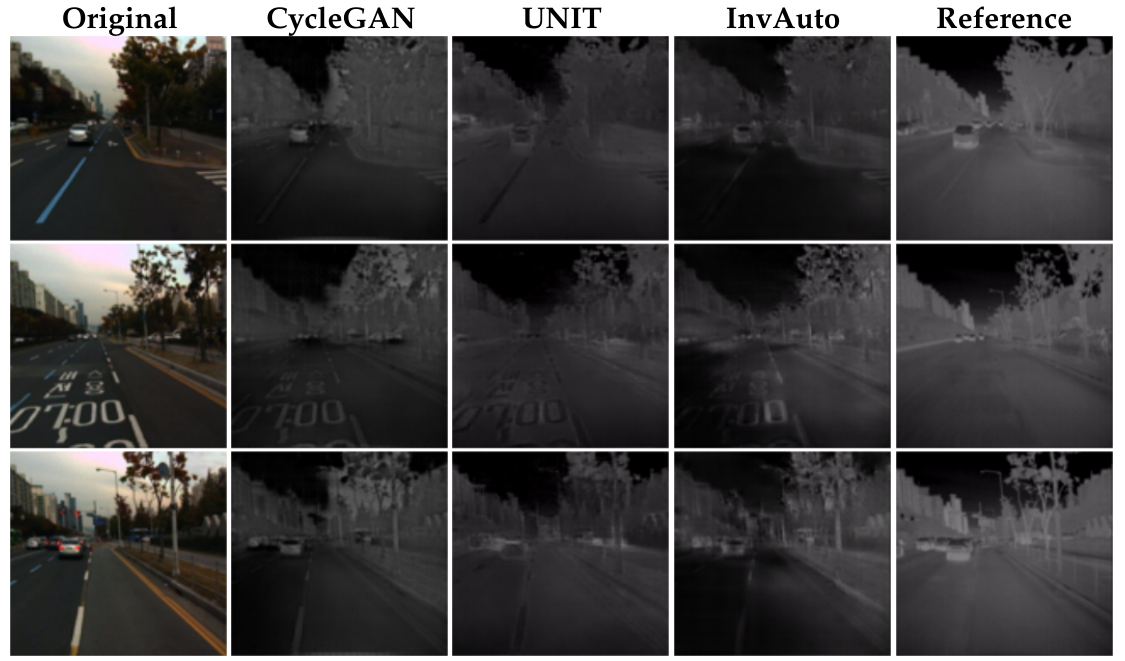
Figure A7. Day-to-thermal image conversion.